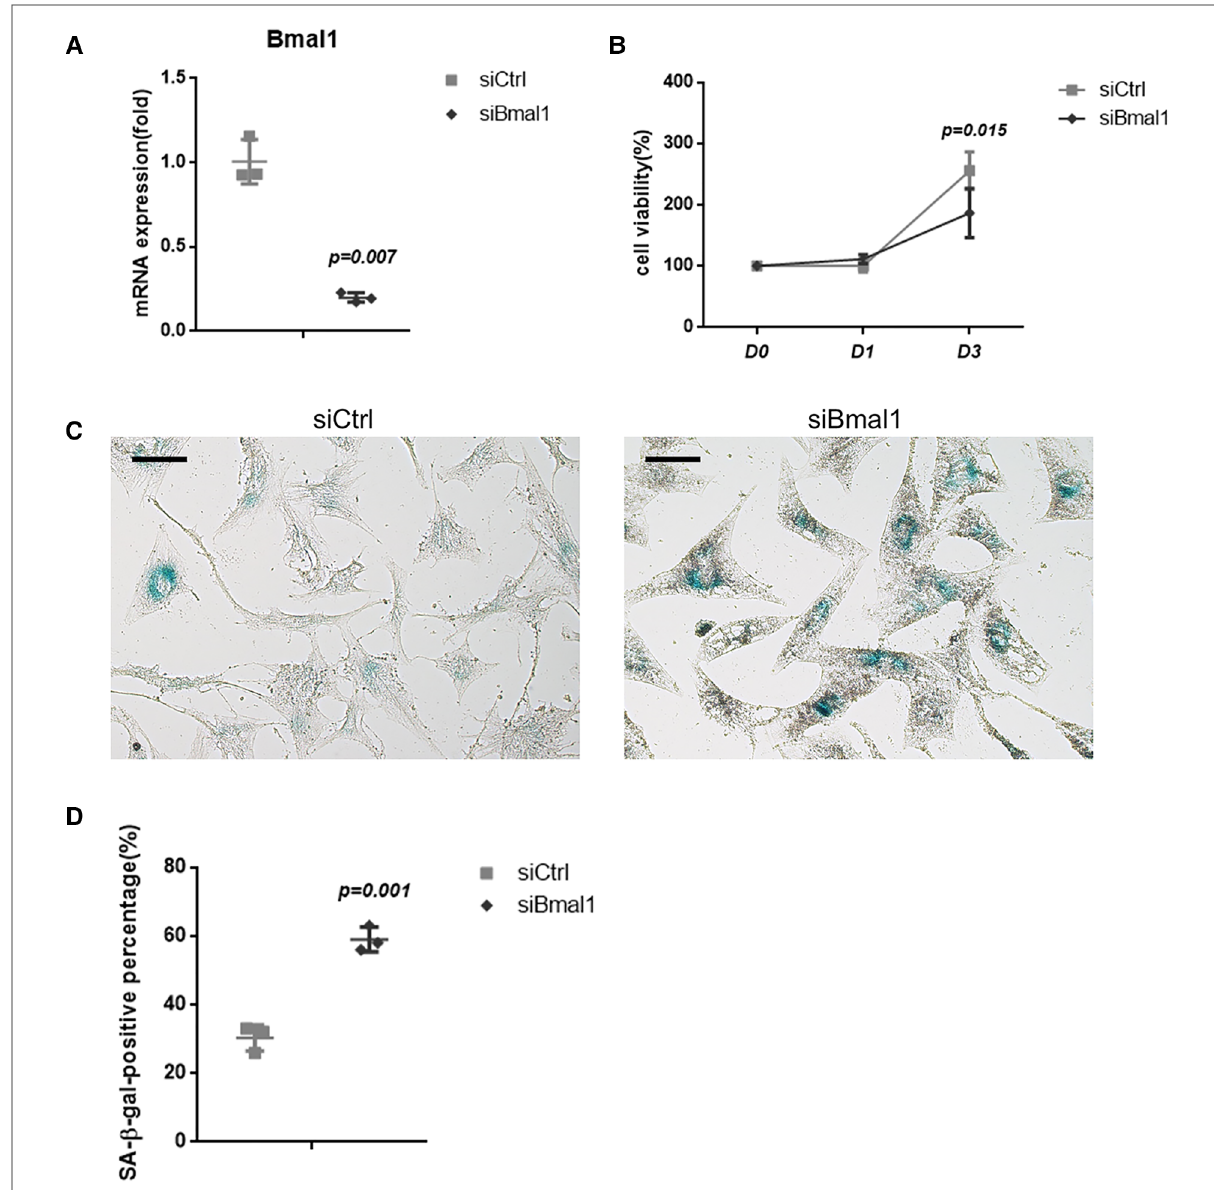
FIGURE 1 Depletion of BMAL1 accelerated cell senescence of BMSCs. ( A ) qRT-PCR test veri fi ed the knockdown ef fi ciency of siBmal1. ( B ) Cell viability of BMSCs after siRNA treatment. ( C ) SA- β -gal staining images of BMSCs after siRNA treatment. Scale bar=100 µm. ( D ) Quantitative analyses of SA- β -gal staining. BMSCs, bone marrow mesenchymal stem cells; qRT-PCR, quantitative reverse transcription polymerase chain reaction; SA- β -gal, senescence-associated β